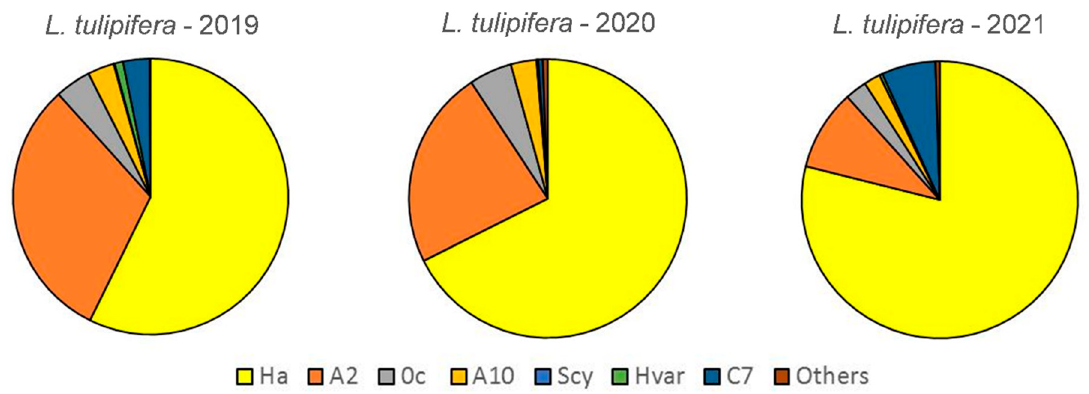
Figure 2. Relative abundance of the different ladybird species on L. tulipifera from 2019 to